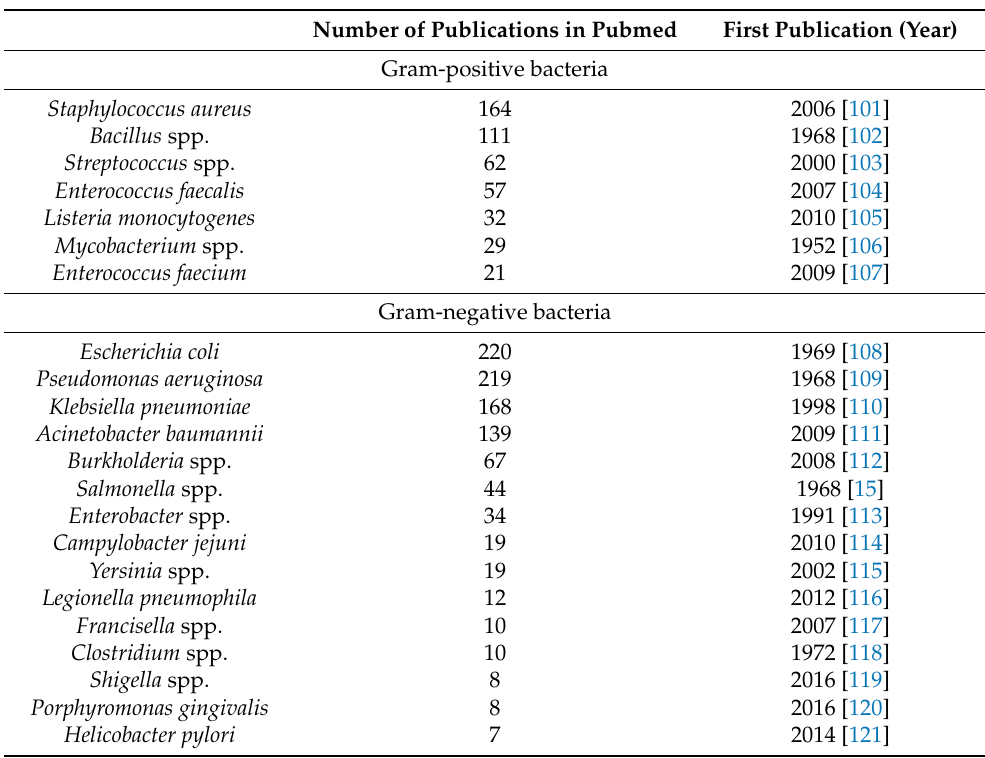
Table 2. Number of publications in Pubmed comprising both the name of the bacterial species or genera and Galleria mellonella , and the year of the first